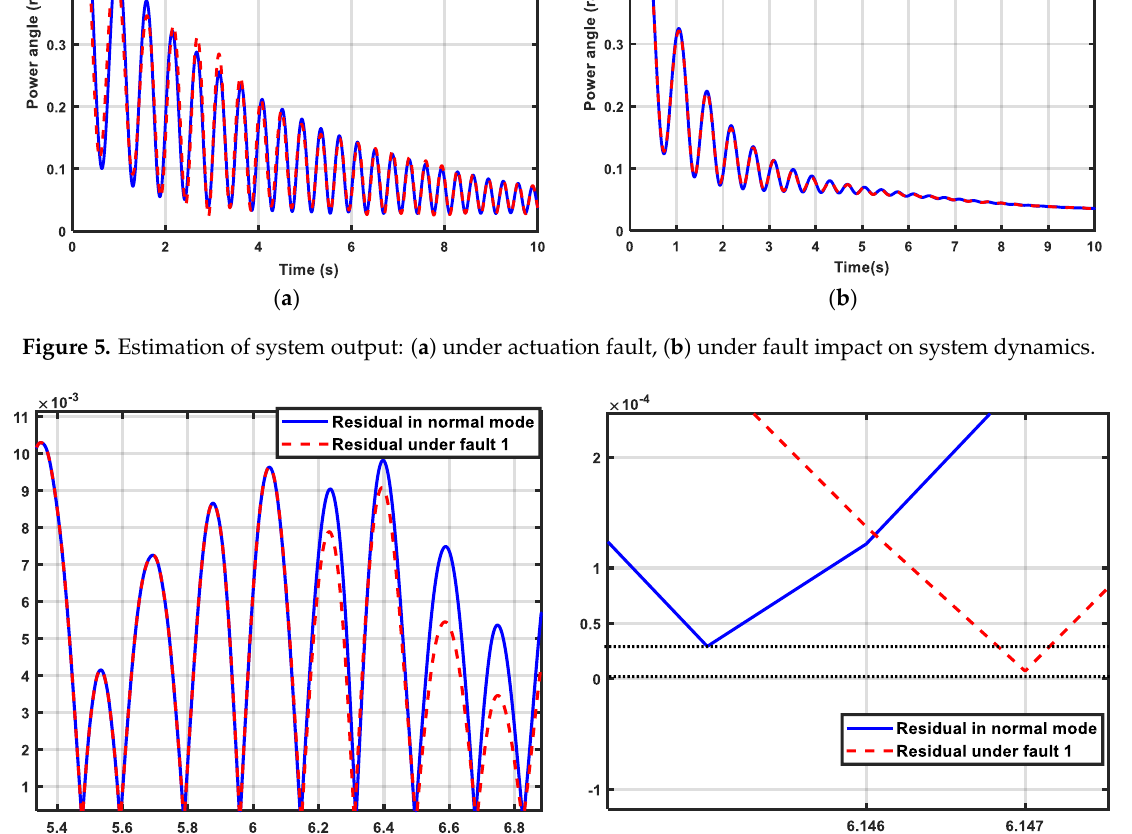
d = 6.147 s, ( b ) zoomed-in